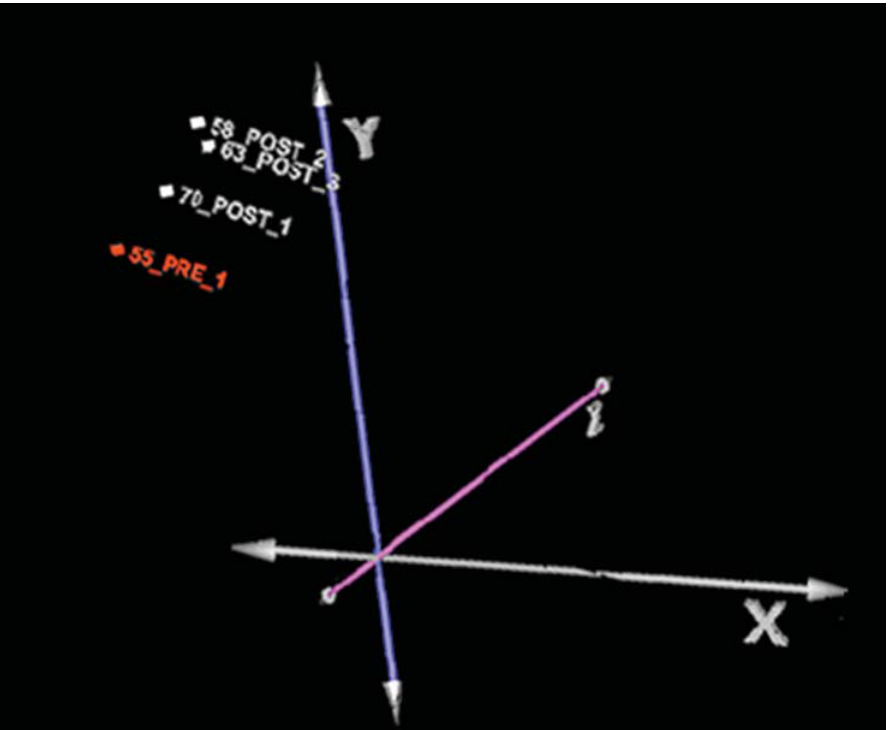
Figure 5. Principal Component Analysis. Principal Component Analysis, showing in three-dimensional space relationship between samples.